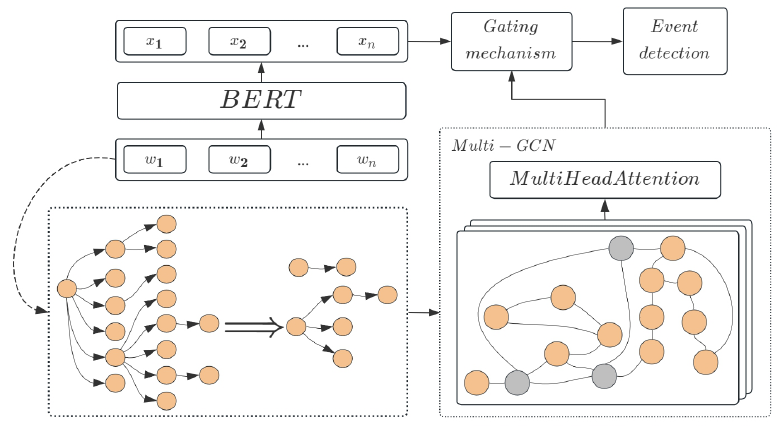
Figure 2. Model graph based on proposed self-constructed dependency graph and graph convolution neural